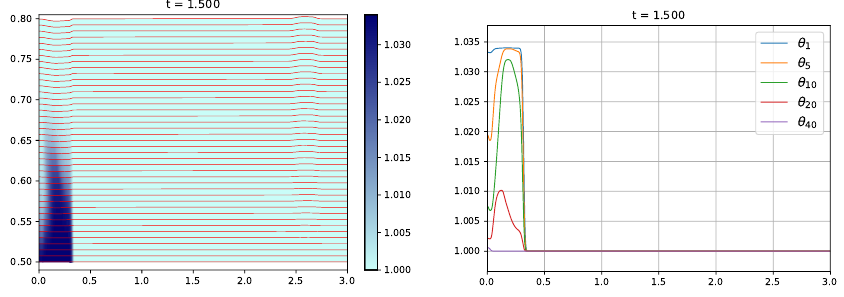
Figure 21. Evolution of the density driven current at t = 1.5 s.